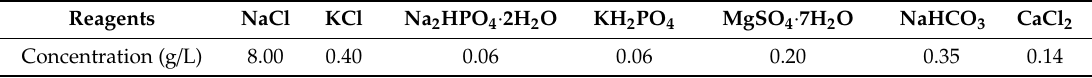
Table 2. Combination ratio of reagents for Hanks’ solution used for the immersion tests.